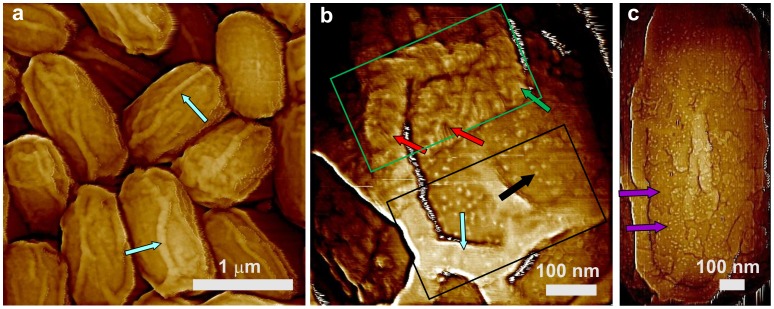
AFM images of cotH spores.(a) Height image of spores with surface ridges extending along the entire length of spores (light blue arrows). (b) High-resolution height image of a spore surface area showing the upper surface area (green rectangle) covered with an amorphous layer (green arrow) and rodlets (red arrows). The lower part of the outermost layer-free area (black rectangle) is covered with nanodots (black arrow). One of the surface ridges in (b) is indicated with a light blue arrow. In panel (c), a two–layer inner coat structure (two purple arrows noting the two layers) decorated with nanodots can be seen.